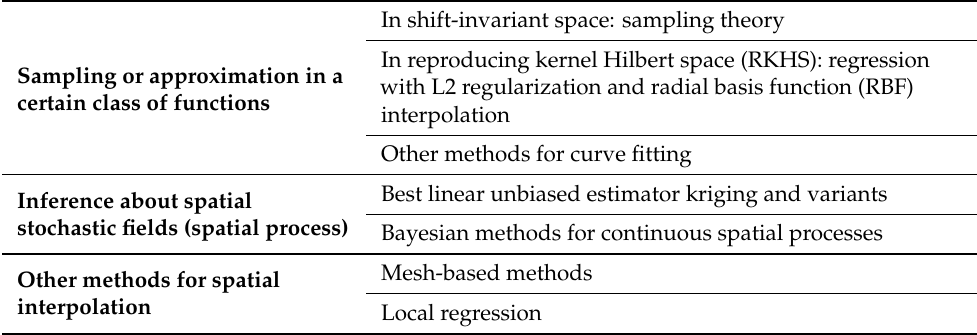
Table 3. Spatial-only interpolation methods for continuous